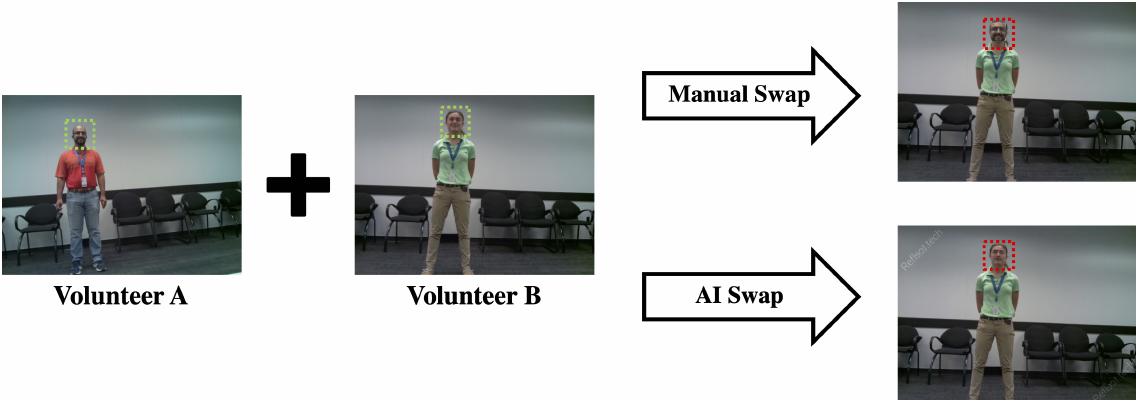
Figure 4. Face swap methodology example. Images are acquired from various people using the same background. Swaps are then performed by manually cropping faces and intelligently blending them using an AI tool.